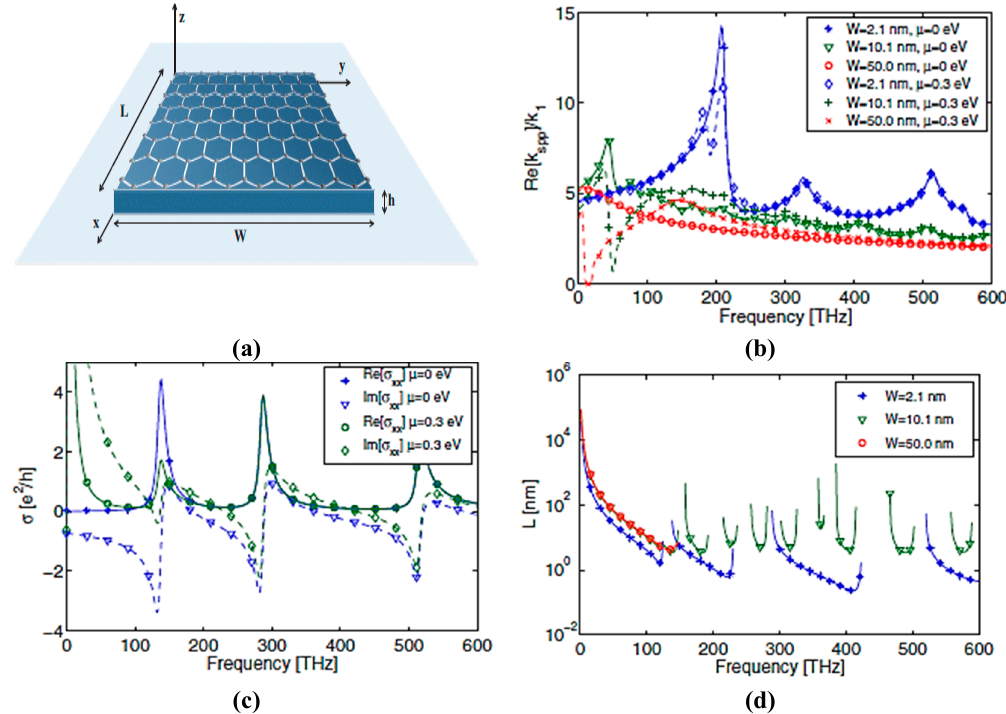
Figure 5. ( a ) Graphene nanoribbon (GNR) antenna; ( b ) real part k spp /k 1 surface plasmon with increasing width of GNR; ( c ) real and imaginary parts of graphene nanoribbon conductivity by keeping the width of patch constant W = 2.1 nm, where the blue line shows the conductivity behavior of GNR at µ c = 0 eV and the green line depicts the conductivity at the chemical potential of µ c = 0.3 eV, by increasing the chemical potential the conductivity shifts to higher frequencies; and ( d ) nanoantenna resonant length L at di ff erent widths of GNR with µ c = 0.3 eV for the transverse magnetic (TM) mode. © Elsevier. Reprinted with permission from [33].